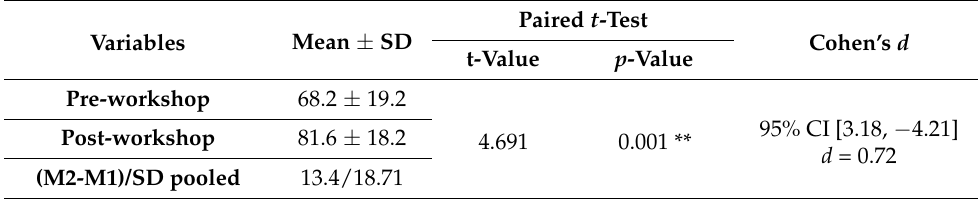
Table 3. Comparison of the effects between pre- and post-ergonomic workshop on the perceived knowledge (Cohen’s d and paired t-test).